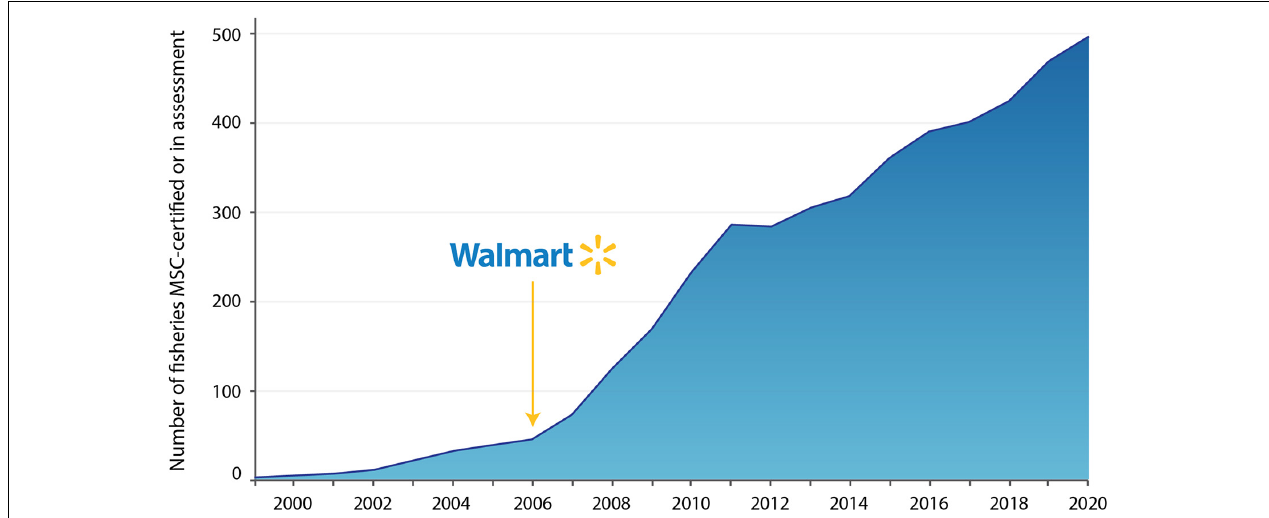
FIGURE 2 | Growth in number of fisheries MSC-certified or in assessment. In January 2006, the world’s largest retailer, Walmart, announced its (unmet) pledge to only sell MSC-certified fish by 2010.